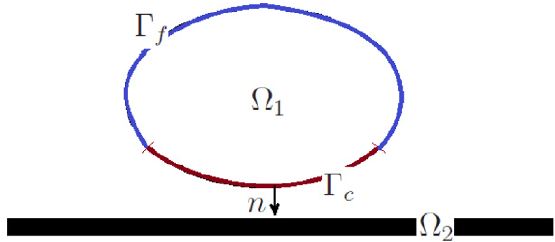
Figure 3. Two bodies in contact.